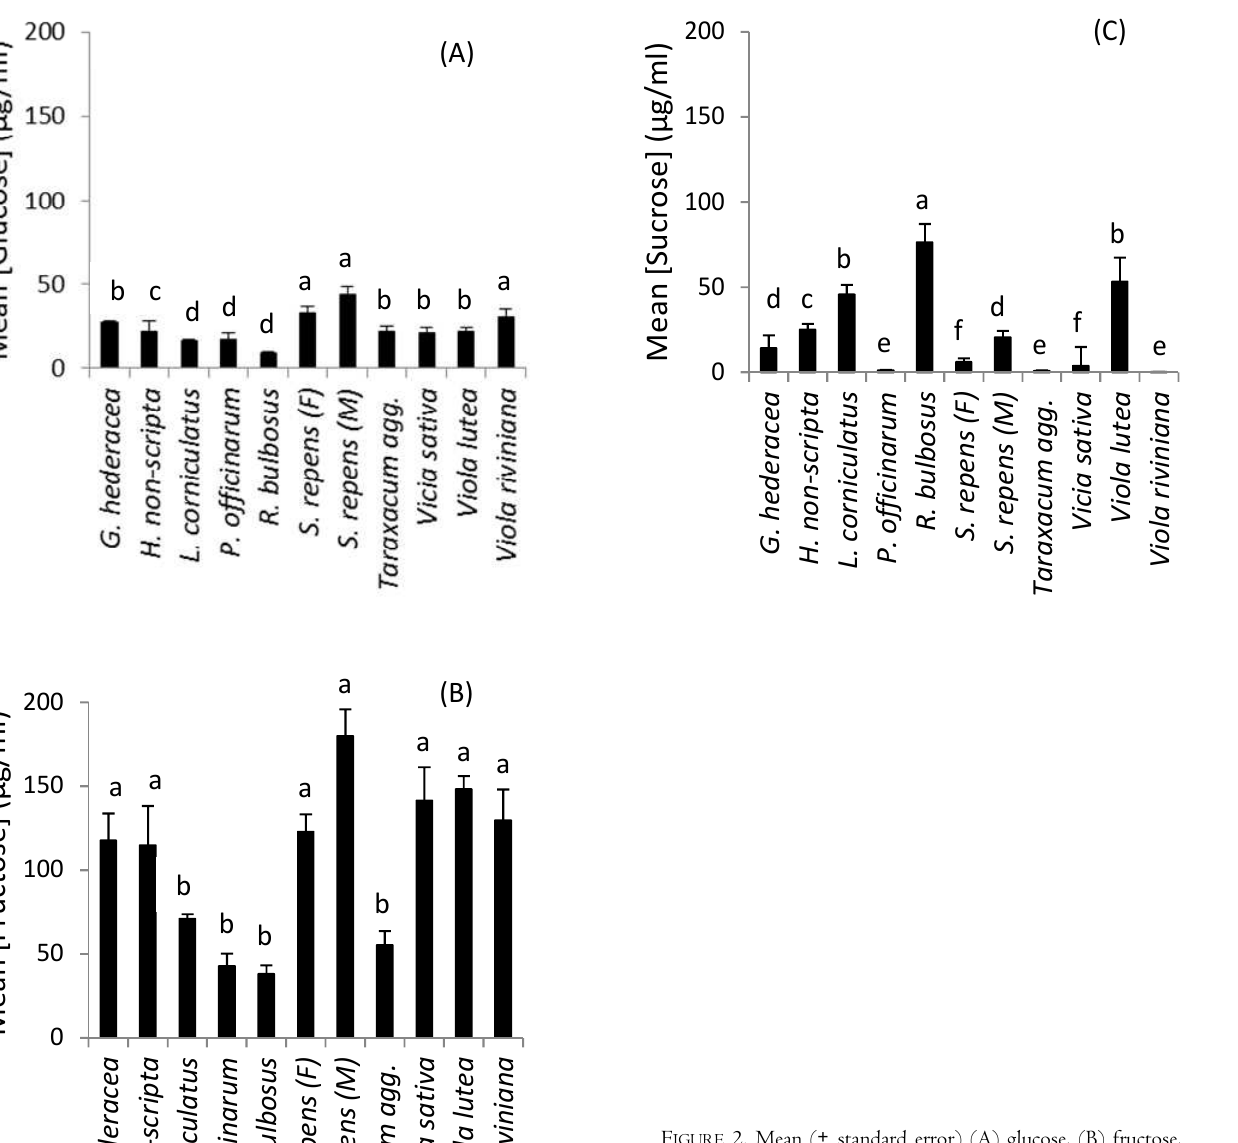
F IGURE 2. Mean ( ± standard error) (A) glucose, (B) fructose, and (C) sucrose concentrations (µg/ml) contained in the nectar of each flowering plant species. Letters above bars represent significant differences between species (Tukey post hoc pairwise comparison, P <